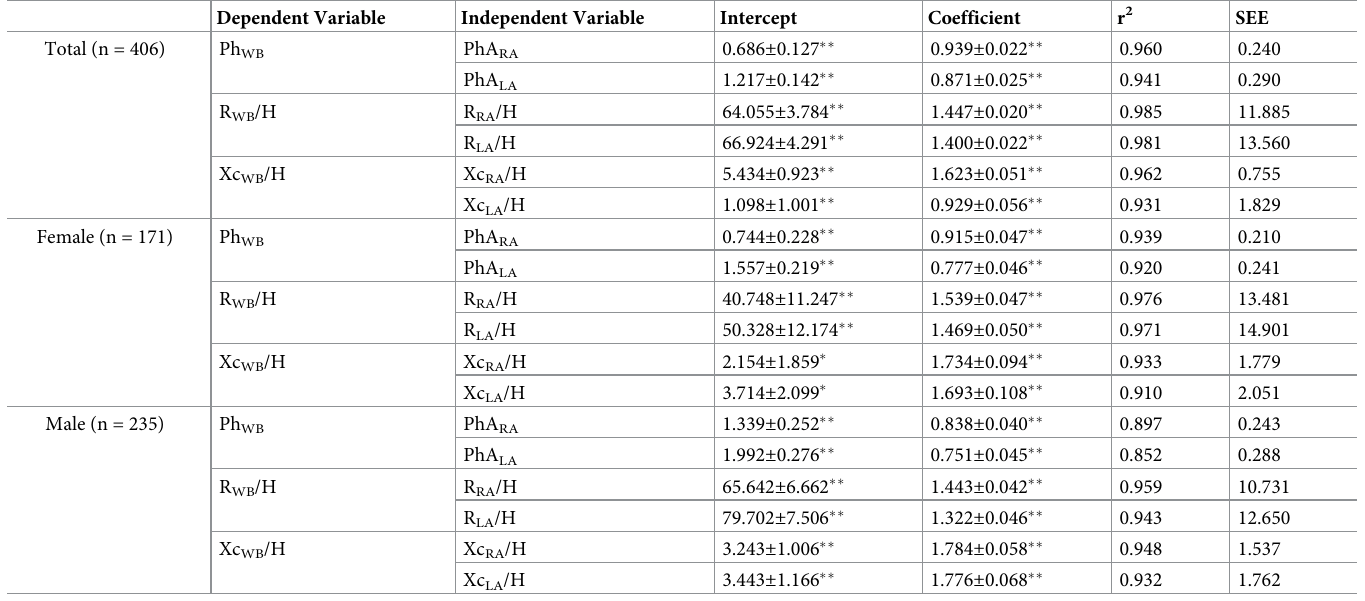
Table 2. Regression analysis of impedance parameters using whole body and segmental